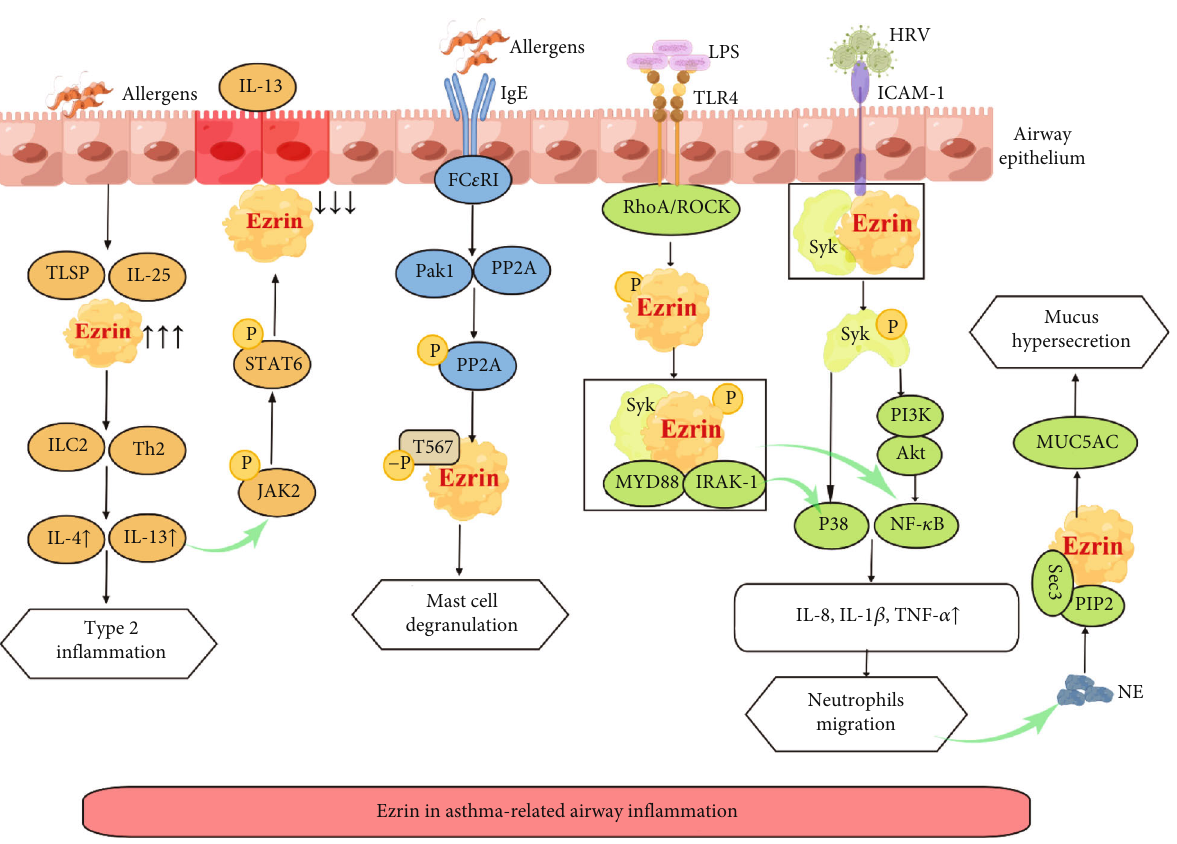
Figure 2: Role of ezrin in asthma-related airway in fl ammation. Abbreviations: ILC2: type 2 innate lymphoid cells; Th2: type 2T-helper cells; P: phosphorylate; -P: dephosphorylate; JAK2: Janus Kinase 2; STAT6: signal transducers and activators of transcription 6; TSLP: thymic stromal lymphopoietin; Fc ε RI: Receptor I for the Fc Fragment of IgE; Pak1: kinase 1; PP2A: protein phosphatase 2A; T567: threonine 567; LPS: Lipopolysaccharide; TLR4: toll-like receptor 4; ROCK: Rho-associated coiled-coil containing protein kinase; MyD88: myeloid di ff erentiation factor 88; IRAK-1: IL-1R-associated kinase 1; HRV: human rhinovirus; ICAM-1: intracellular adhesion molecules-1;